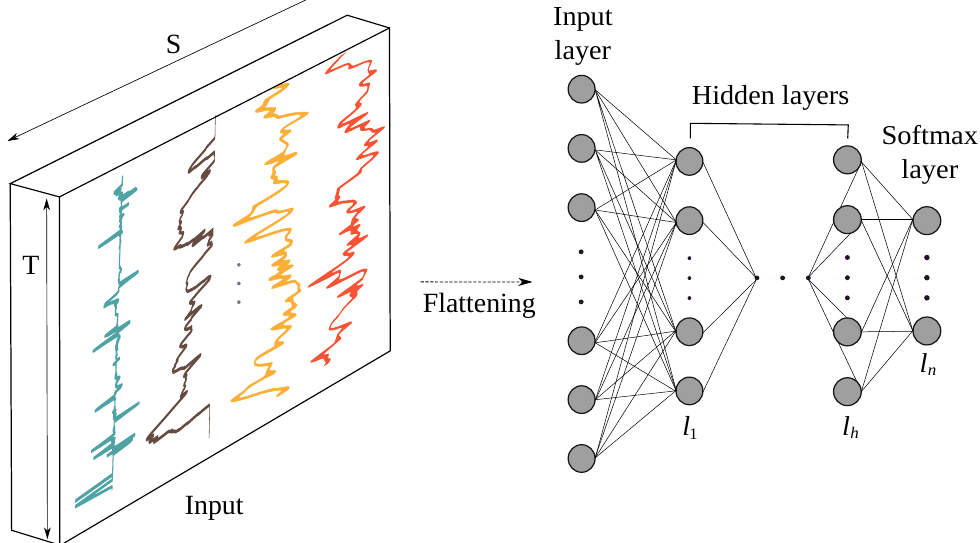
Figure 3. Architecture of a MLP model for accident detection with h hidden layers, n number of classes and S number of sensor channels. Input data are first flattened into a ( T × S ) -dimensional vector and and then fed to the hidden layers. All layers are fully